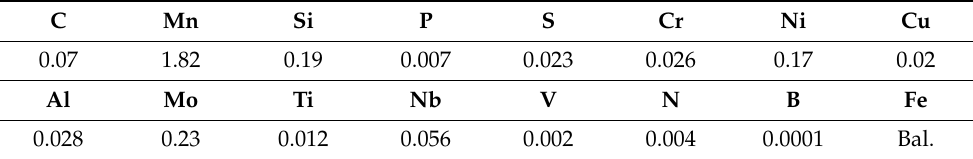
Table 1. Chemical composition of X80 steel